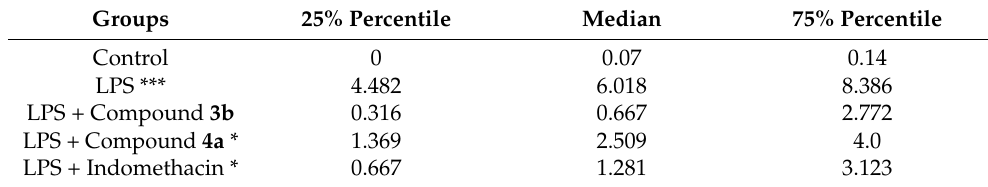
Table 8. Effects of compounds 3b , 4a, and indomethacin on NO levels ( µ mol/L). Groups 25% Percentile Control